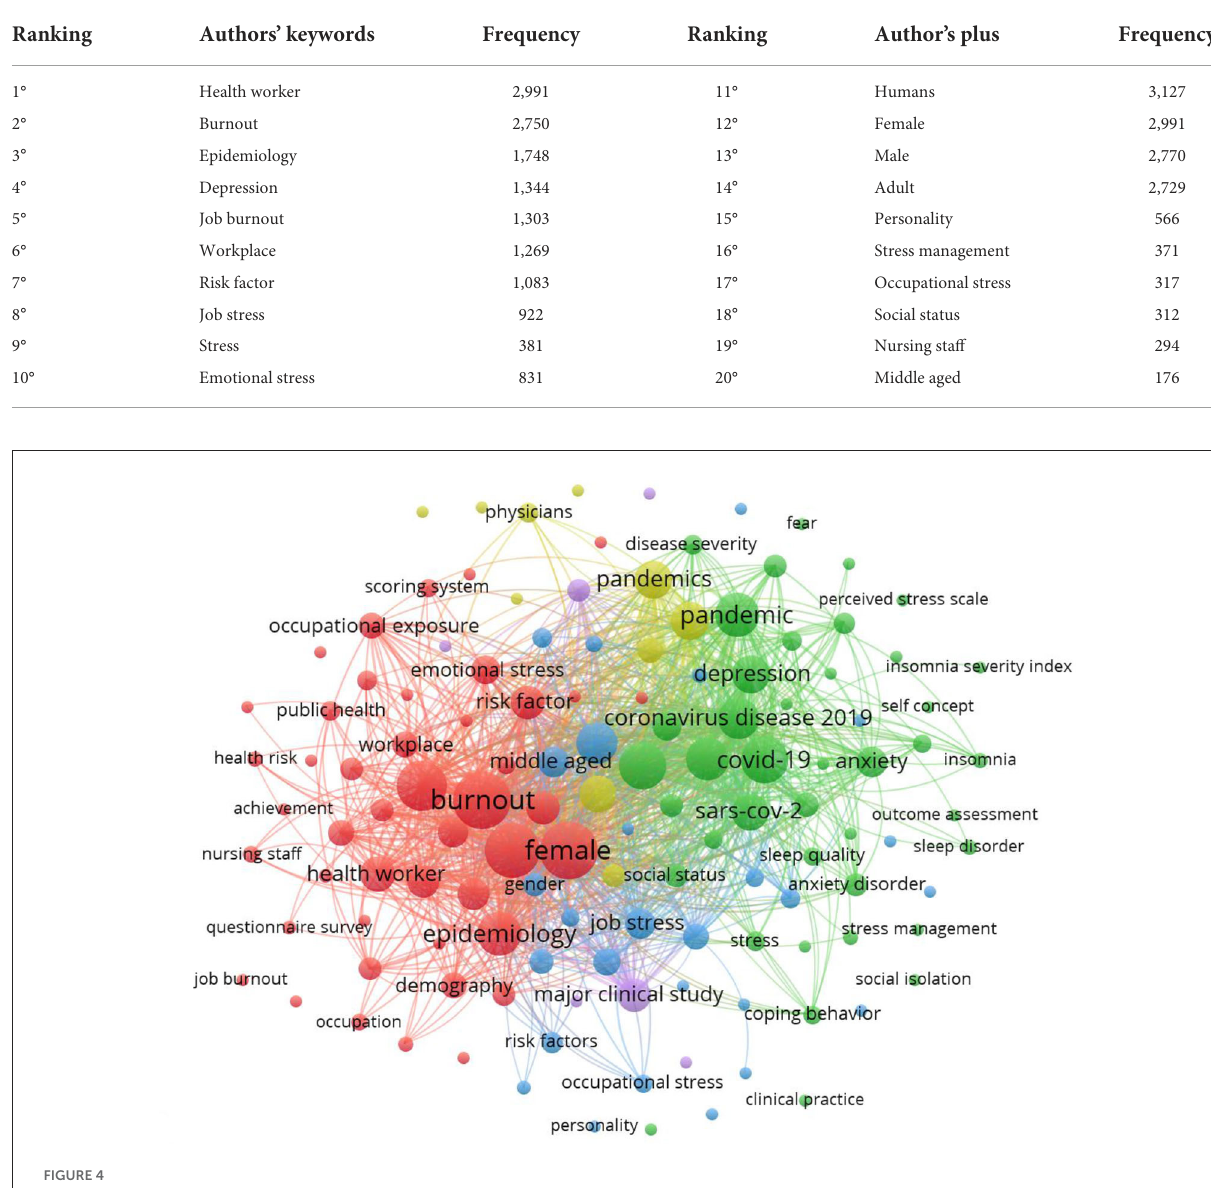
FIGURE4 Mapping authors’